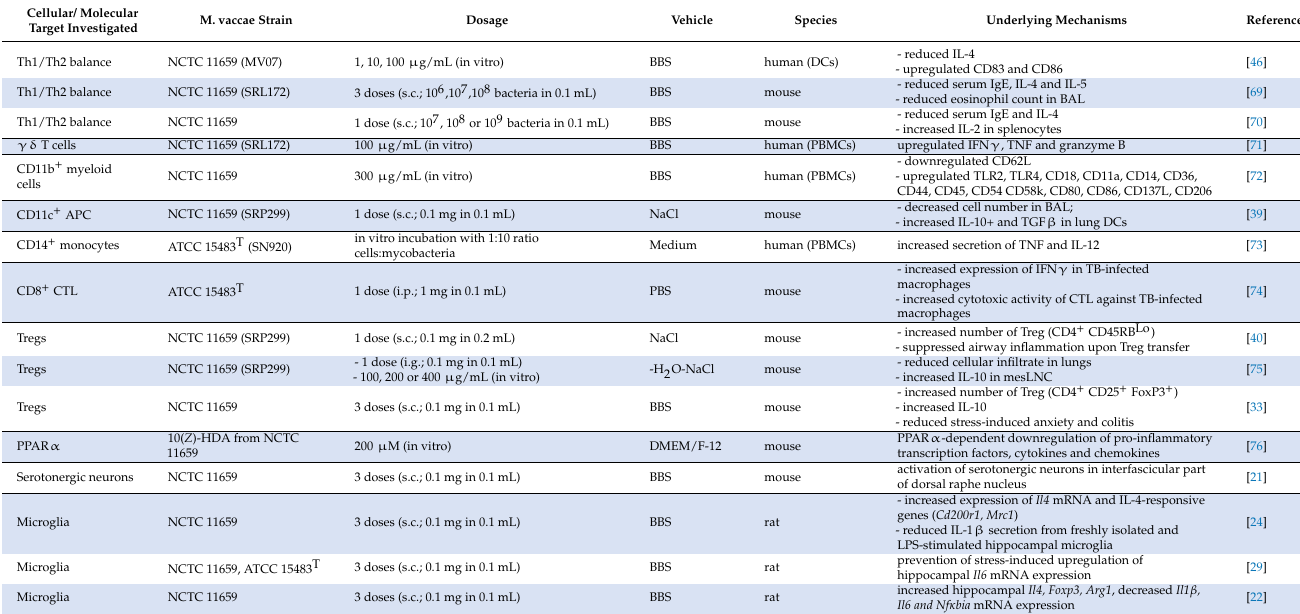
Table 4. List of preclinical studies investigating the underlying mechanisms induced by rapidly growing mycobacteria strains (RGMs) 1